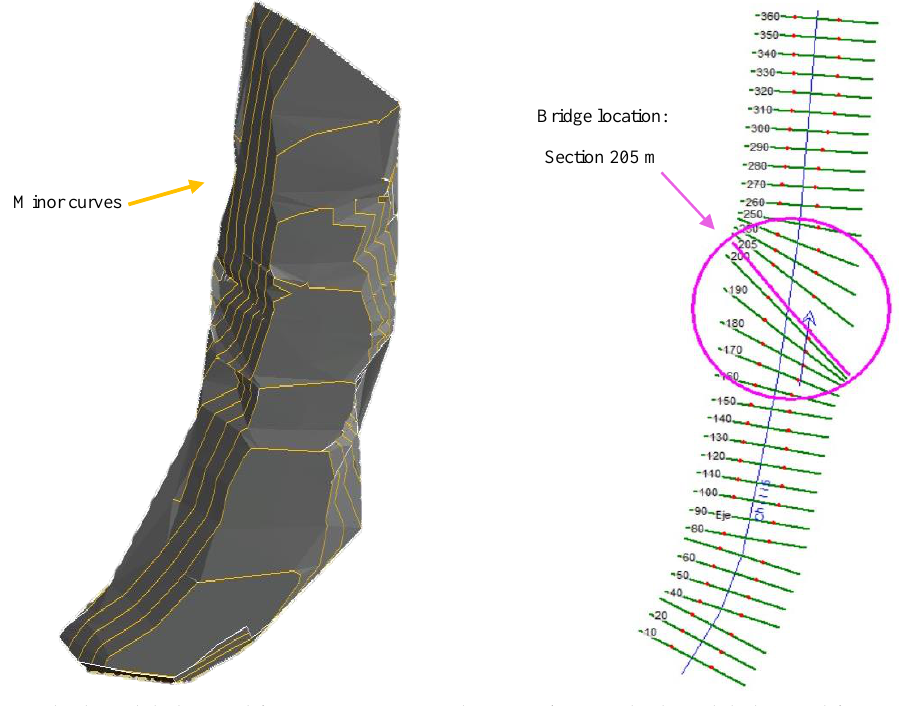
Figure 2. Erosion on the deck of the bridge.